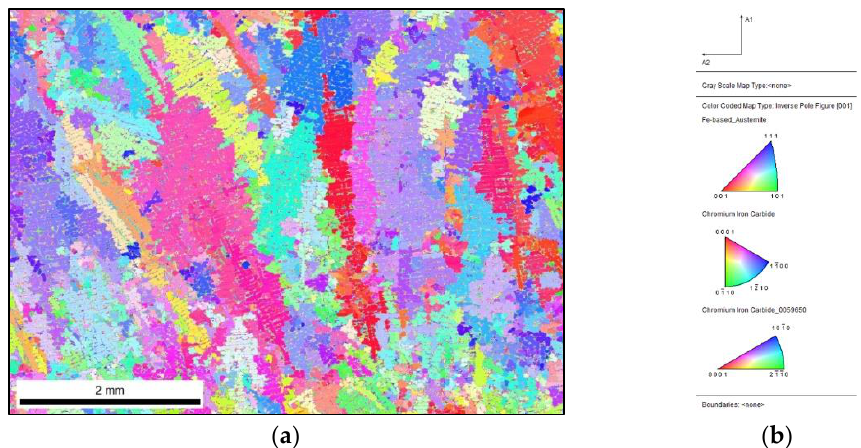
Figure 9. Inoculated sample with 0.33% Fe – Ti: ( a ) IPF map with marked primary grains; ( b ) refer- ence triangle.